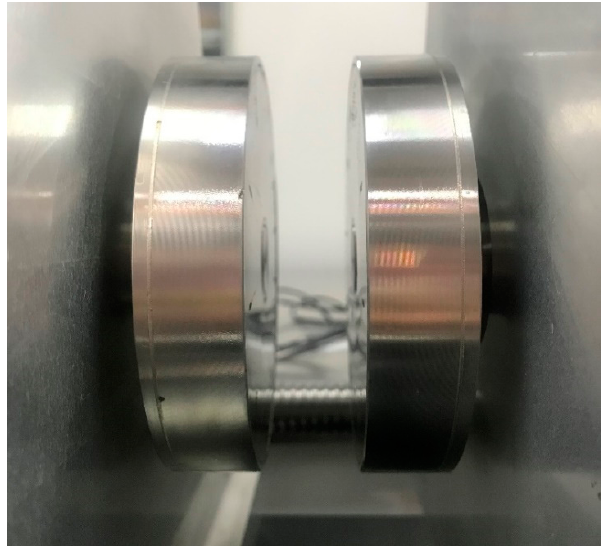
Figure 14. The prototype of the optimized magnetic coupling.